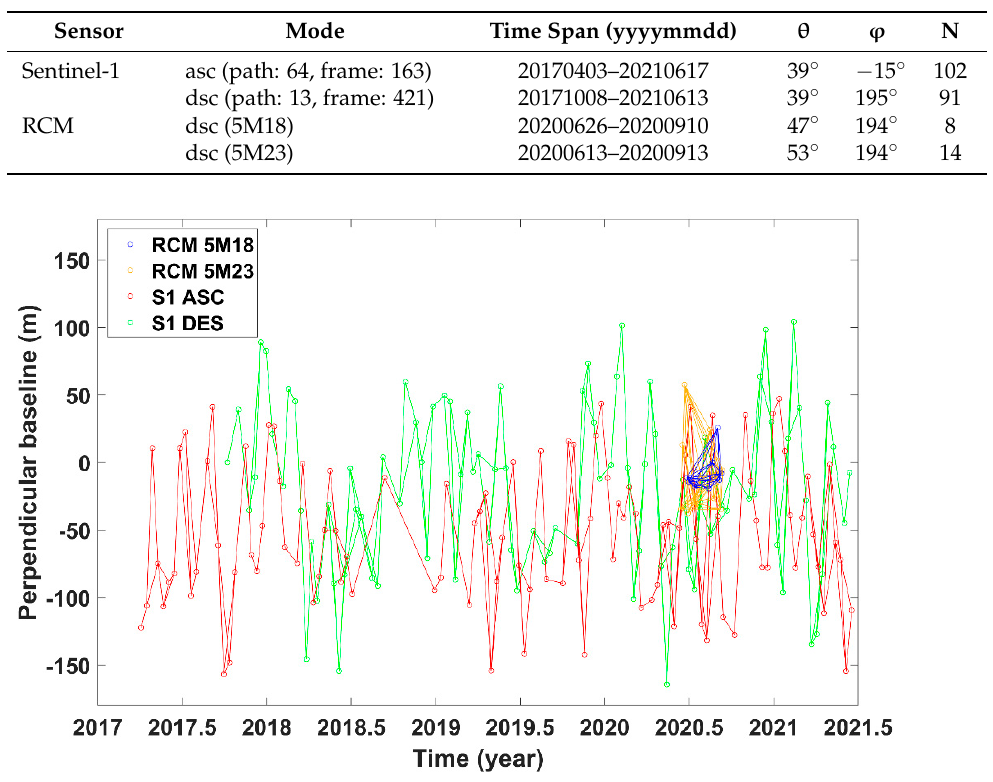
Table 1. Sentinel-1 and RCM datasets used in this study ( θ : incidence angle, φ : azimuth angle, N: number of SLC images).